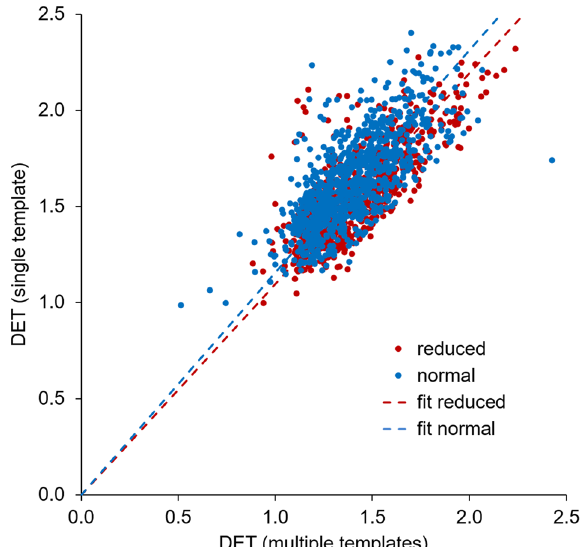
Fig. 5 Scatter plot of the amount of stretching with the two normalization methods. The scatter plot of the DET of the affine transformation for stereotactical normalization with the single template versus DET with multiple templates includes the 1665 cases in which the binary categorization by the minimum hottest voxels SBR agreed between single template and multiple templates stereotactical normalization. The dashed lines indicate the result of linear regression, separately in the normal and in the reduced